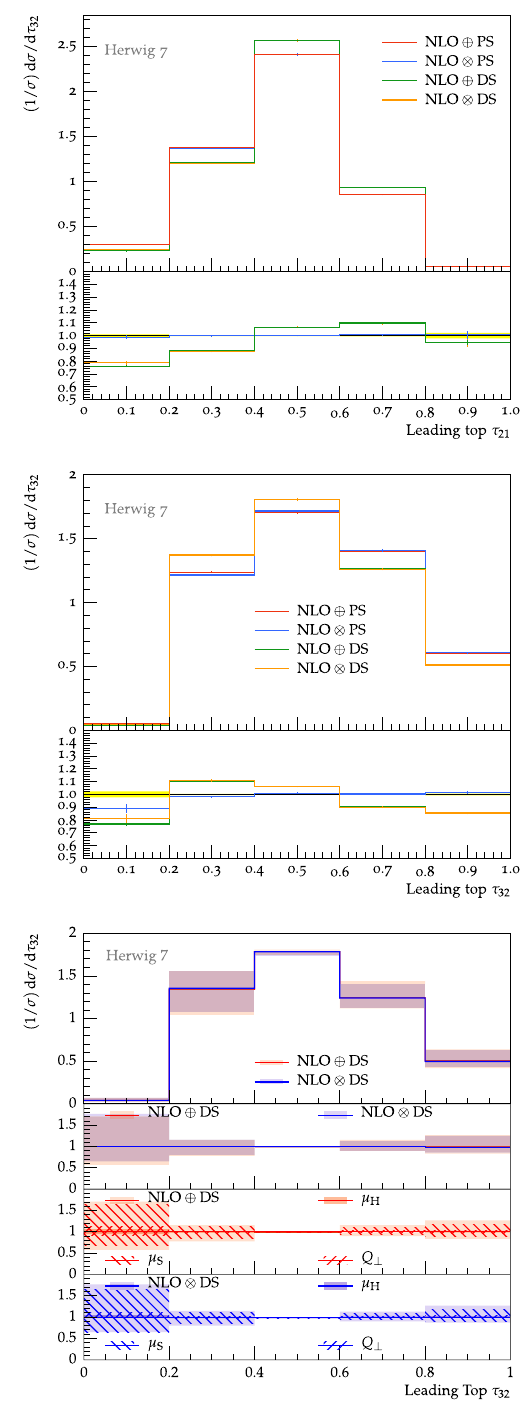
Fig. 16 The N-subjettiness ratios τ 21 (top) and τ 32 (middle and bot- tom) for the large-radius jet associated with the highest momentum top-quark in boosted t ¯ t events. The top and middle plots show com- parisons of the angular-ordered (PS) and dipole (DS) showers with both the MC@NLO-type (NLO ⊕ ) and Powheg-type (NLO ⊗ ) match- ing schemes. The bottom plot shows the effects of scale variations on τ 32 using the dipole shower with each of the NLO matching